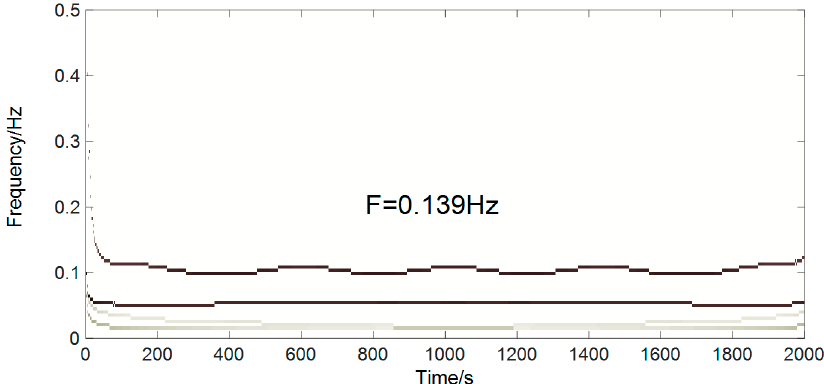
Figure 16. Hilbert marginal spectrum of the denoised observation sequence in the horizontal direction.